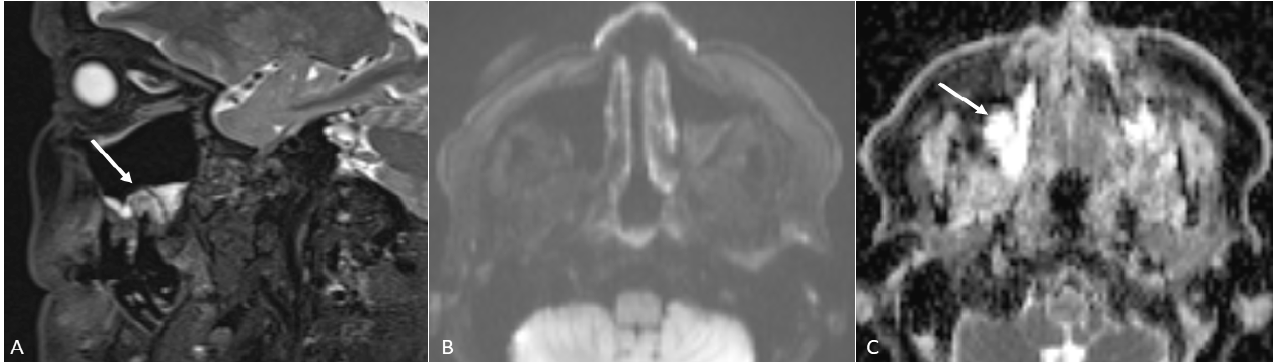
Figure 7. Periapical cysts. MRI . ( A ) Sagittal T2 image. ( B ) DWI trace b = 1000. ( C ) ADC map. Periap- ical cyst (white arrows) results from dental infections that spread to the tooth apex and into the adjacent bone. It is often bordered by a thin rim of cortical bone as can be observed in ( A ). In ( B , C ) the absence of restricted diffusion is highlighted since no hyperintense signal on DWI trace and high values on ADC map (2.27 × 10 − 3 mm 2 /s) are found.